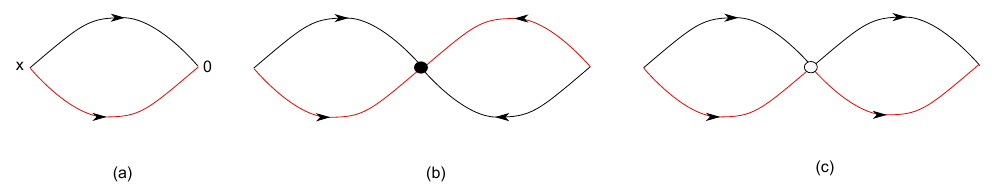
Figure 4 . Feynman diagrams contributing to the correlation function h O XZ ( x ) O (cid:22) Born approximation (a) and at one-loop (b,c). Filled and open circles in diagrams (b) and (c) denote single- and double-trace vertices, respectively. Black and red lines represent the propagators of scalar (cid:12)elds X and Z , respectively, with arrows pointing from X to (cid:22) X and from from Z to (cid:22) Z . The sum of diagrams (b) and (c) vanishes at the (cid:12)xed point (1.4). (cid:15) Type